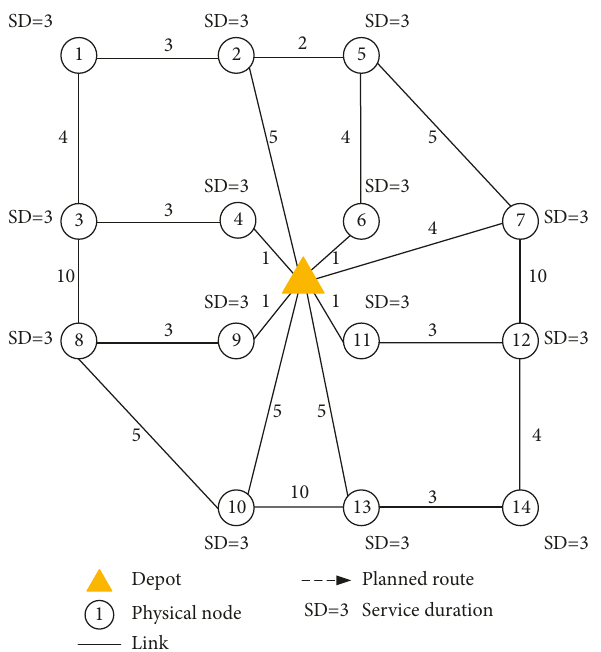
Figure 7: Physical network for the illustrative example.